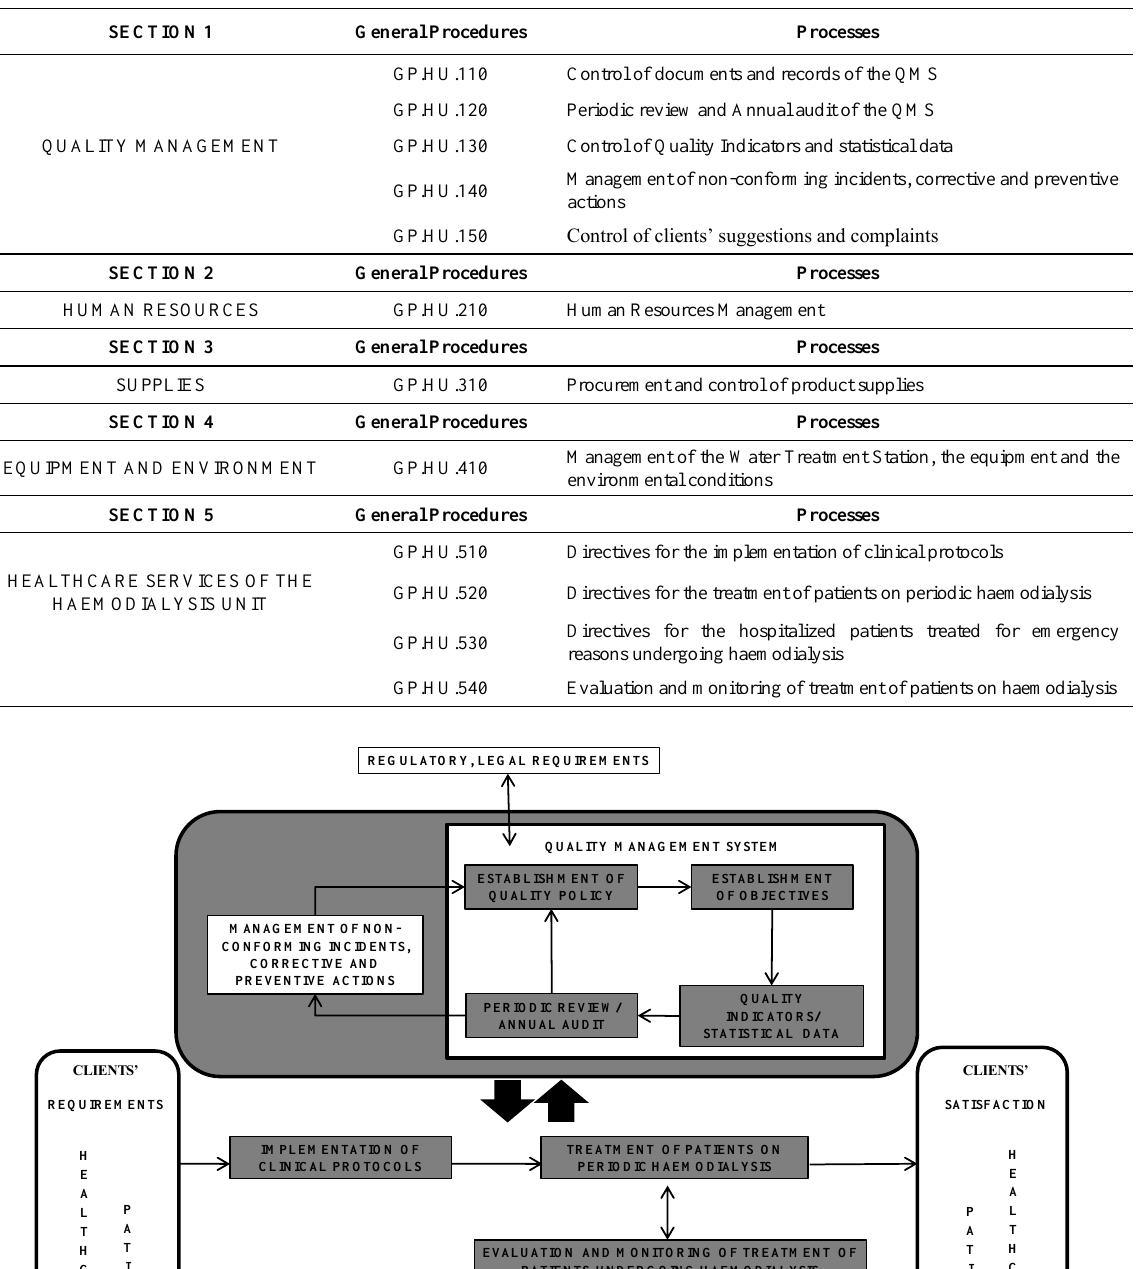
Table 1. General Procedures of the Haemodialysis Unit